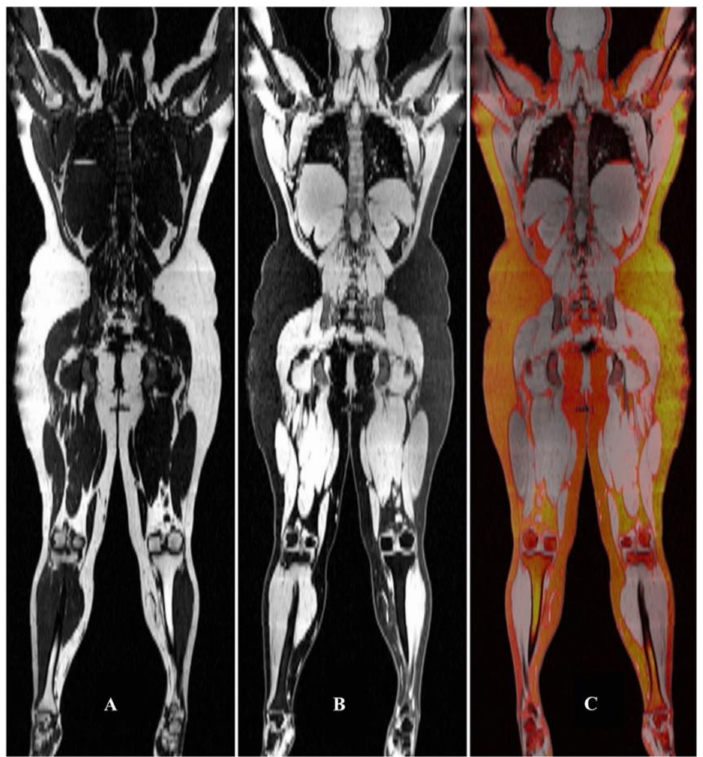
Figure 1. Separated fat ( A ) and water ( B ) MRI of an obese individual. Panel ( C ) depicts the fat overlayed in color on the water grayscale image. From Seabolt et al. (2015), with